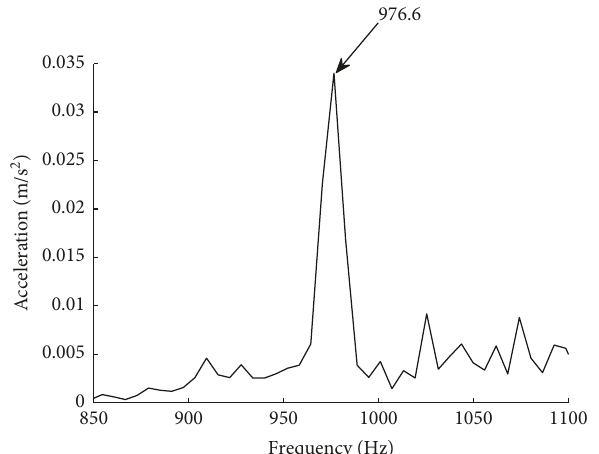
Figure 11: The acceleration-response spectrum corresponding to effective tension 306.6kN. (cid:31)